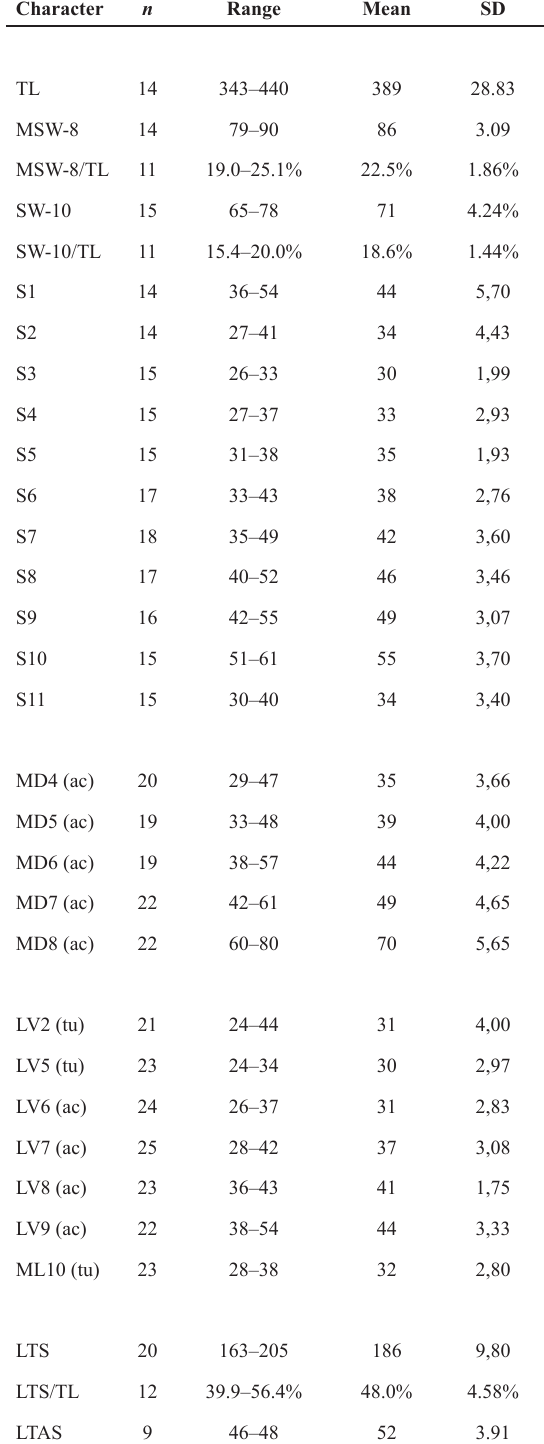
Table 9. Measurements from light microscopy for lectotype and nine paralectotypes of Echinoderes pilosus Lang, 1949 from Grytviken, South Georgia Island (in µm), including number of measured specimens ( n ) and standard deviation